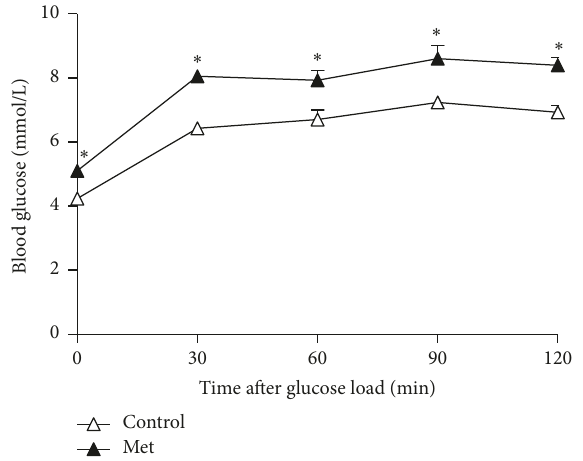
Figure 2: Glucose concentrations during the oral glucose tolerance test (OGTT) in the control-diet group ( 𝑛 = 6 ) and the Met-diet group ( 𝑛 = 6 ) at the 48th week. Values are mean ± SEM. ∗ 𝑝 < 0.005 versus the control-diet